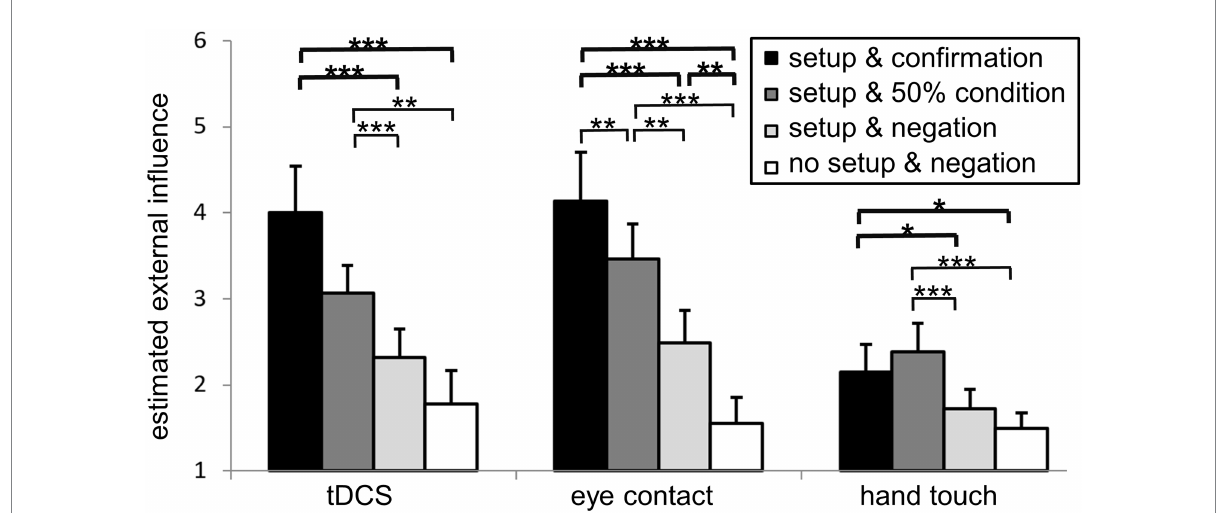
FIGURE 4 External influence estimation comparing the different setups and conditions. Effect of condition separately per setup. “Setup & confirmation” (black), “setup & 50% condition” (dark grey), “setup & negation” (light grey) and “no setup & negation” (white) are given for tDCS, eye contact, and hand touch. Results of hypothesis driven analyses comparing the conditions are marked with bold lines and asterisks above, exploratory analyses in slim lines and asterisks below. * p ≤ 0.05, ** p ≤ 0.005, *** p ≤ 0.001. Mean values and standard error of the means are depicted.